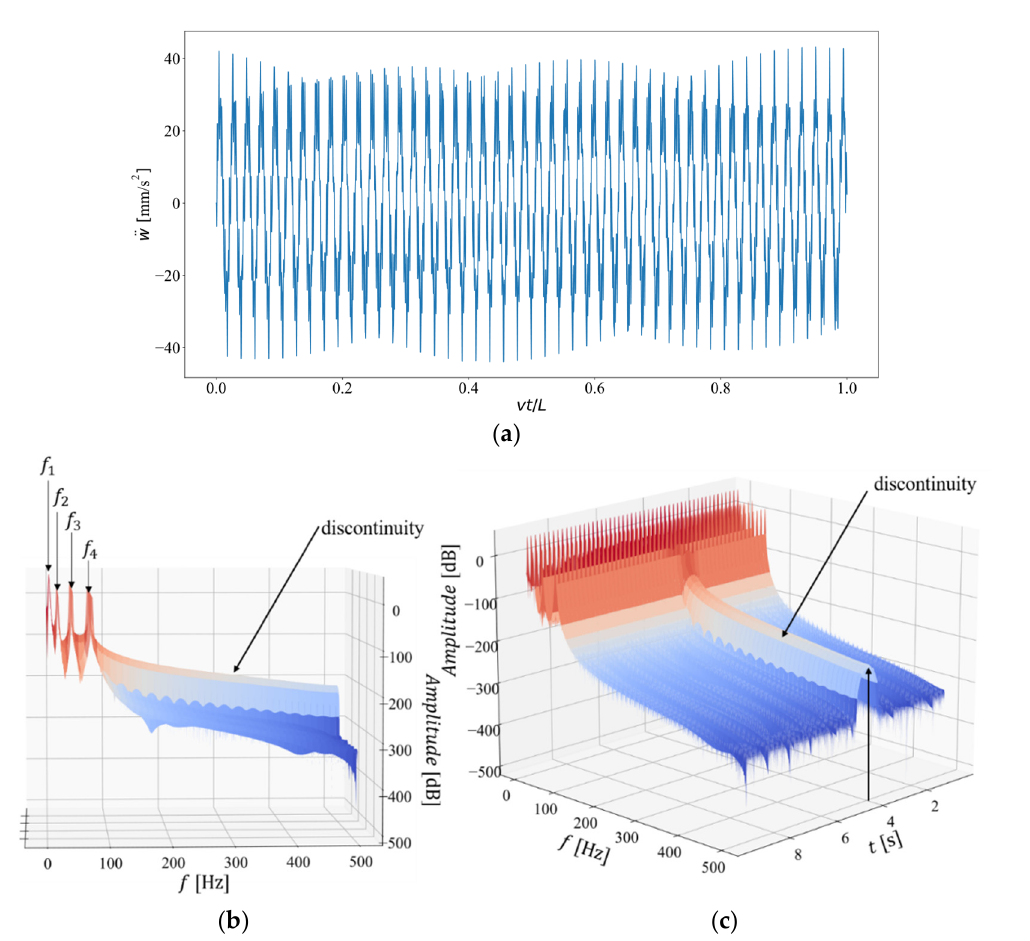
Figure 6. Simply-supported beam with a vertical crack of length 𝛼 = 10 mm at station 𝐿 (cid:2869) = 2.00 m traversed by a point force 𝑃 with constant velocity 𝑣 : ( a ) Acceleration time history 𝑤(cid:4663) (mm/s (cid:2870) ) at station 𝐿 (cid:2869) = 2.00 m , ( b ) Fourier transformed acceleration amplitude 𝑊(dB ) showing the first four eigenfrequencies 𝑓 (cid:3036) (Hz) and ( c ) Time-frequency spectrum of the acceleration amplitude 𝑊(dB ) showing a discontinuity at time 𝑡 = 4 s . Note that colors indicate energy intensity in the signal.